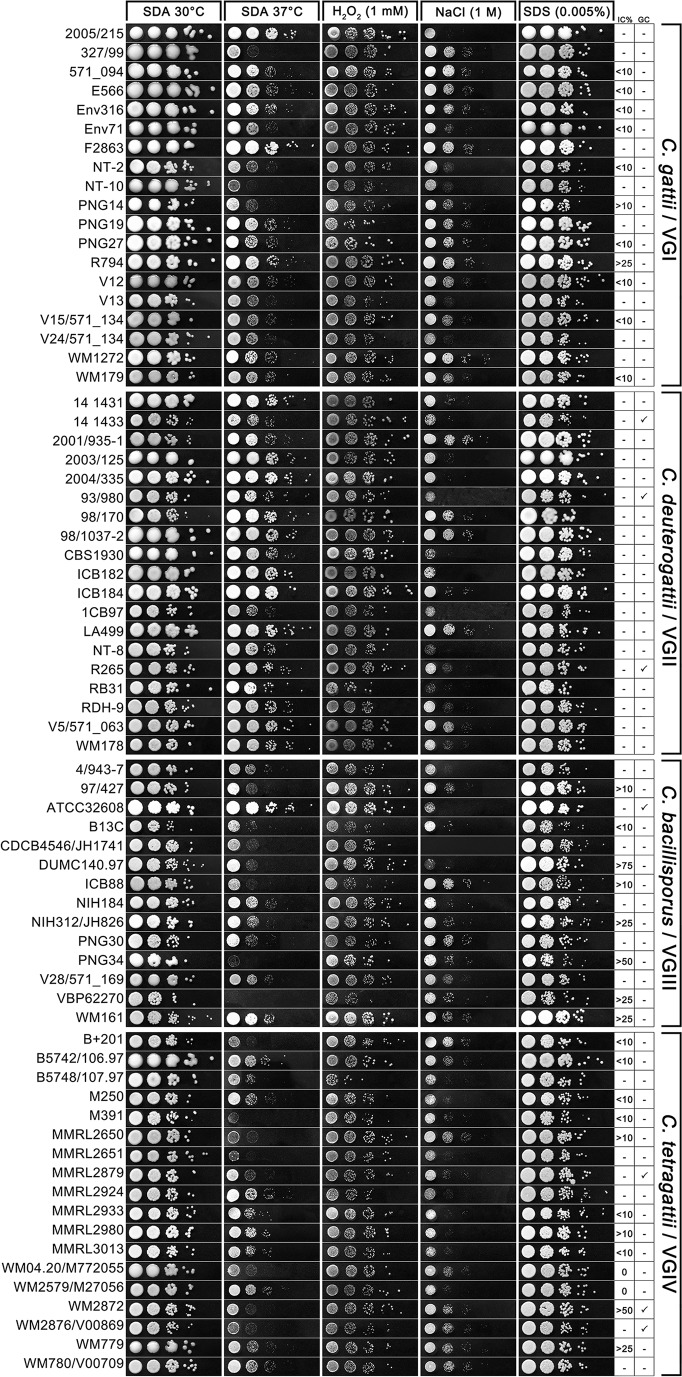
Stress tolerance spot plate assays of strains in the C. gattii species complex. Strains from each species were spotted in a 10-fold dilution series. For each strain, from left to right, the cryptococci are shown starting at 106 cells/ml on unsupplemented SDA and incubated at 30°C and then shown grown on unsupplemented SDA and incubated at 37°C, and SDA supplemented with either 1 mM H2O2, 1 M NaCl, or 0.005% SDS and incubated at 30°C. Results were read after 48 h. The percentage of irregular cells (IC%) and presence (checkmark) or absence (−) of giant cells (GC) are shown to the right of the images.